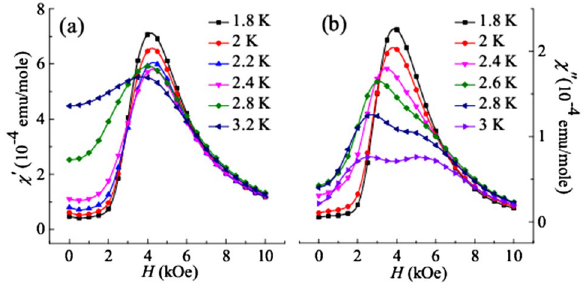
Figure 3. ( a,b ) Real ( χ ʹ ) and imaginary ( χ ʹʹ ) part of the AC susceptibility (AC field = 2 Oe, and frequency = 331 Hz) at various temperatures below T N , plotted as a function of applied DC field.